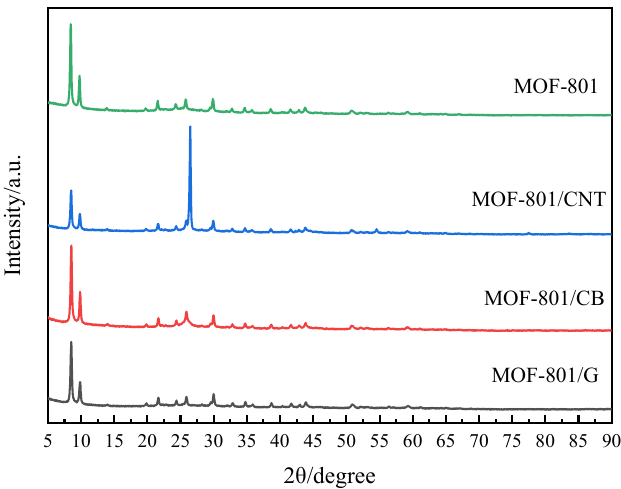
Figure 2. XRD Image of MOF-801, MOF-801/CNT, MOF-801/G, and MOF-801/CB.